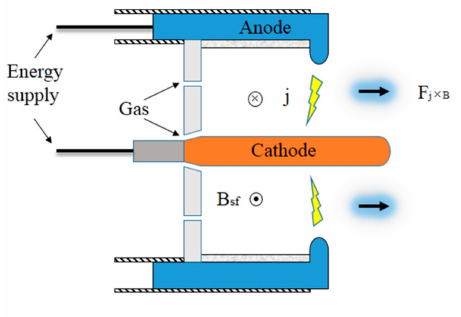
Figure 1. Schematic of self-field magnetoplasmadynamic thruster